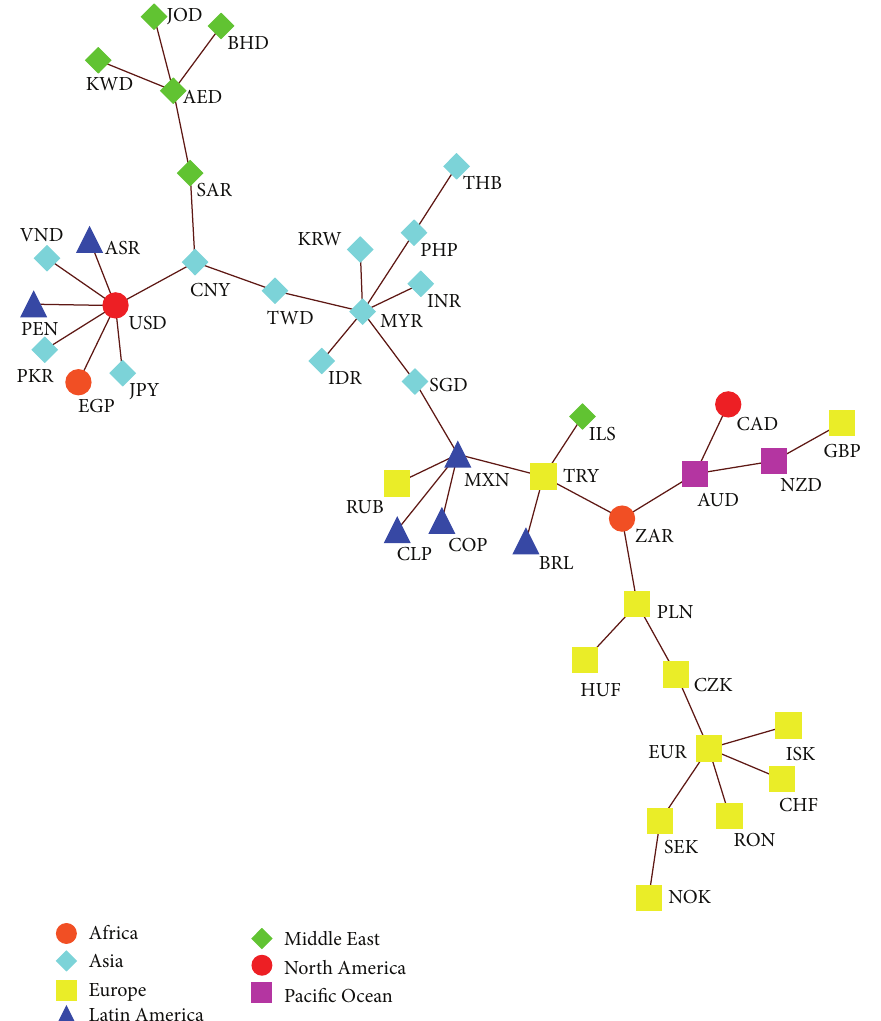
Figure 5: MST of 42 currencies in the international FX market on January 3, 2012, as a representative of the period of after financial crises.